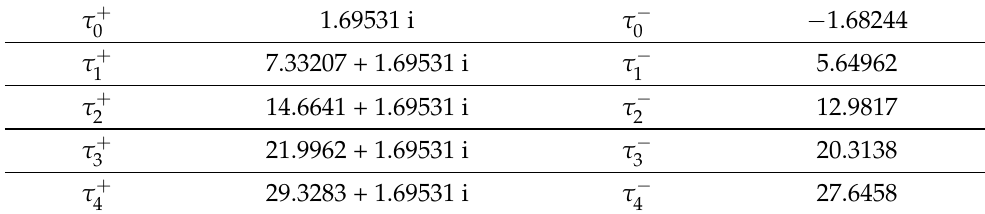
and τ − for n = 0,1,2,3,4. k k